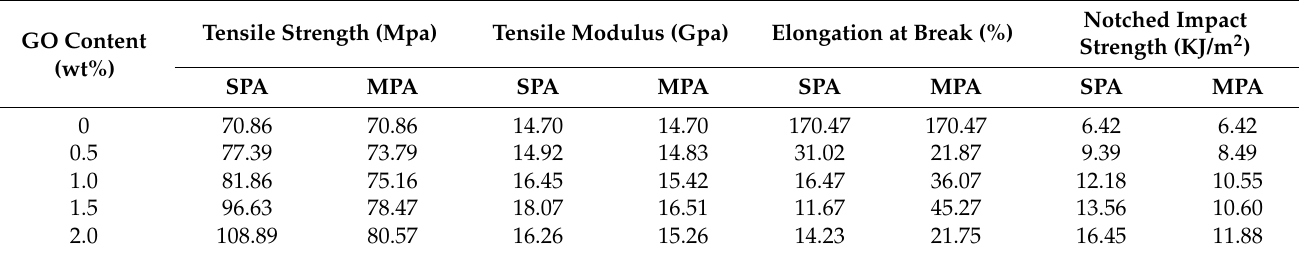
Figure 13. Mechanical parameters of SPA composites and MPA composites: ( a ) Tensile strength and Tensile modulus; ( b ) Elongation at break; ( c ) Notched impact strength. Figure 14. Scanning electron microscopy (SEM) images of tensile section: ( a ) PA10T/1012: ( b ) MPA- Table 5. Mechanical properties of SPA composites and MPA composites.